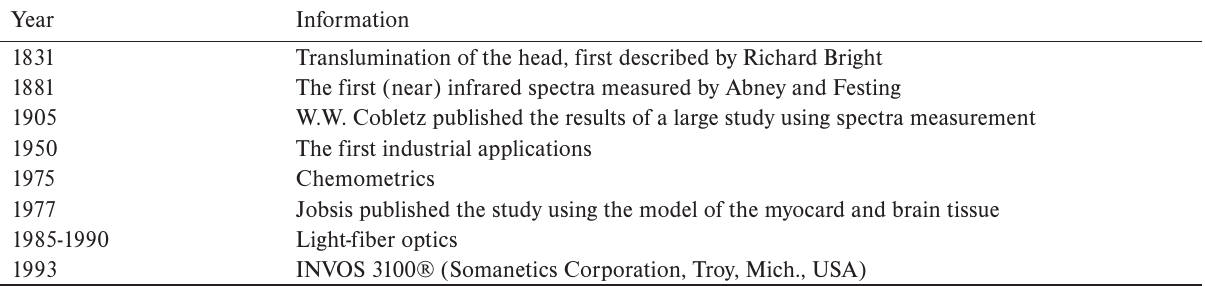
Table 1. NIRS technology evolution 4-6,8